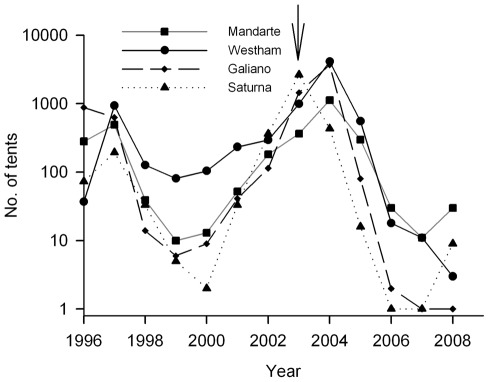
Population cycles of Malacosoma californicum pluviale tents.Number of Malacosoma californicum pluviale tents per study site on four islands in southwestern British Columbia, Canada from 1996 to 2008 [20]. The egg masses used to obtain larvae for the genetic analysis were produced by moths in 2002 and would have been part of the larval population in 2003 (arrow).